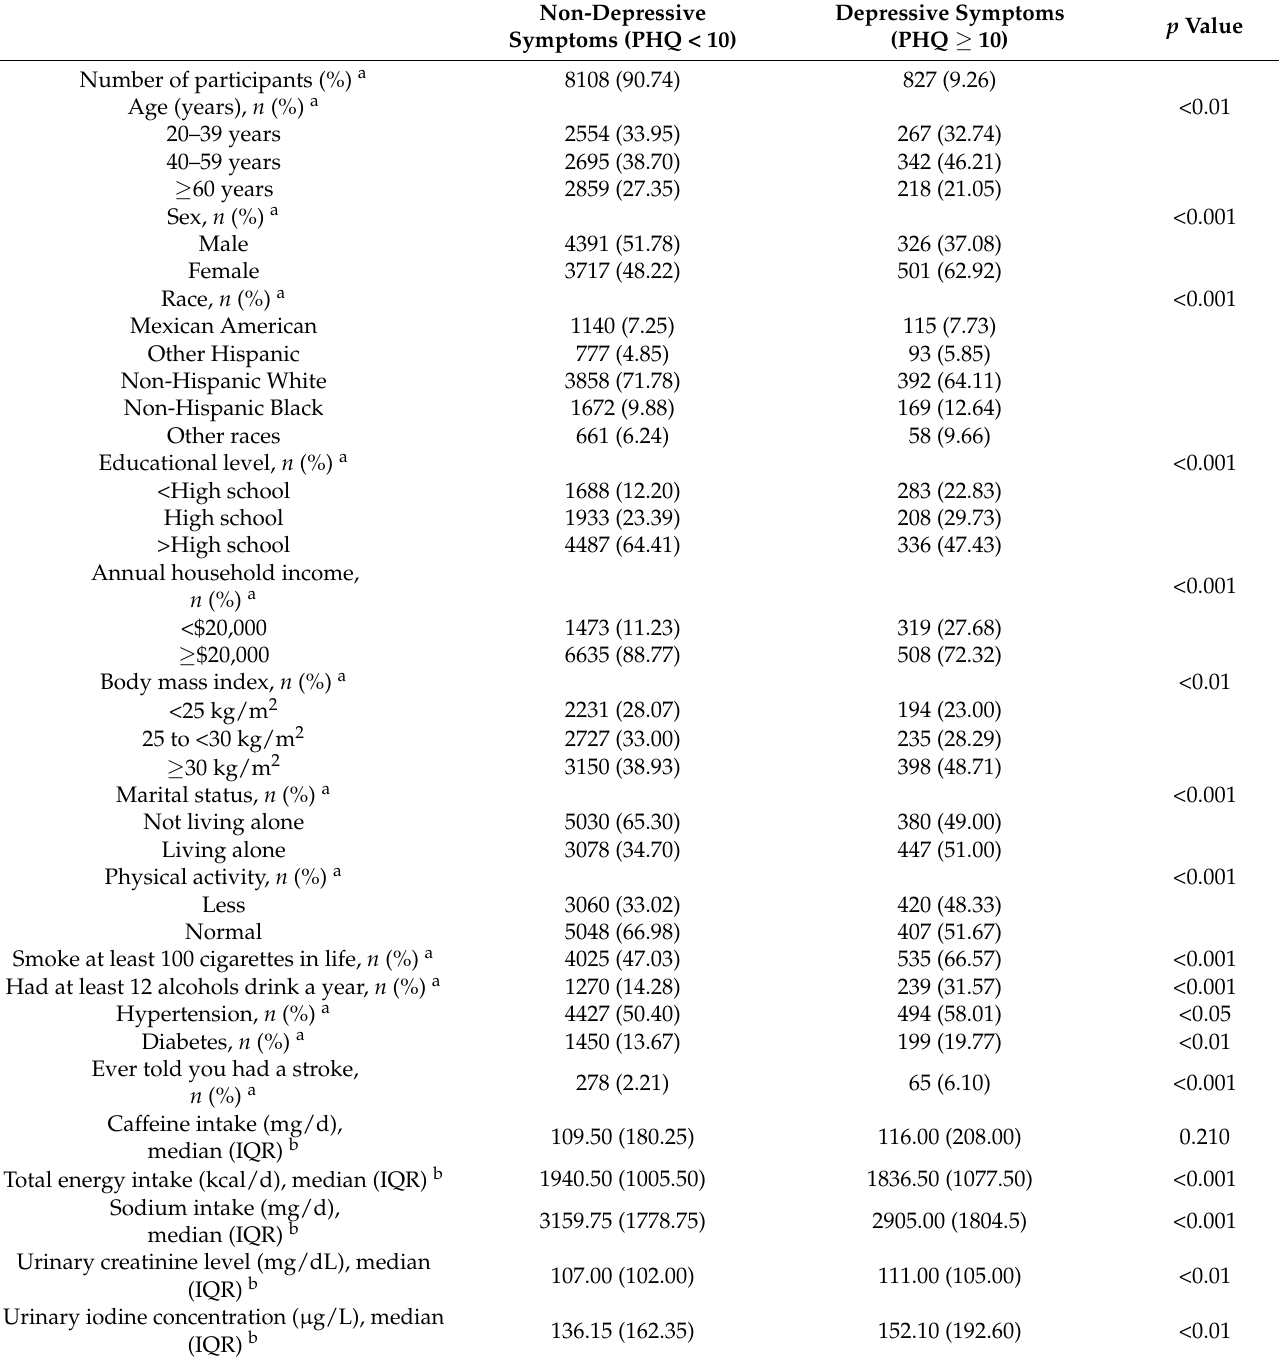
Table 1. Baseline characteristics of participants, NHANES 2007–2018 ( N = 8935).